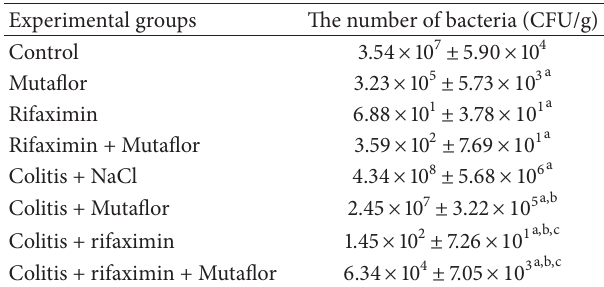
Mean value ± SEM. 𝑁 = 8 observations in each experimental group. a 𝑃 < 0.05 compared to control; b 𝑃 < 0.05 compared to colitis + NaCl; and c 𝑃 < 0.05 compared to colitis +